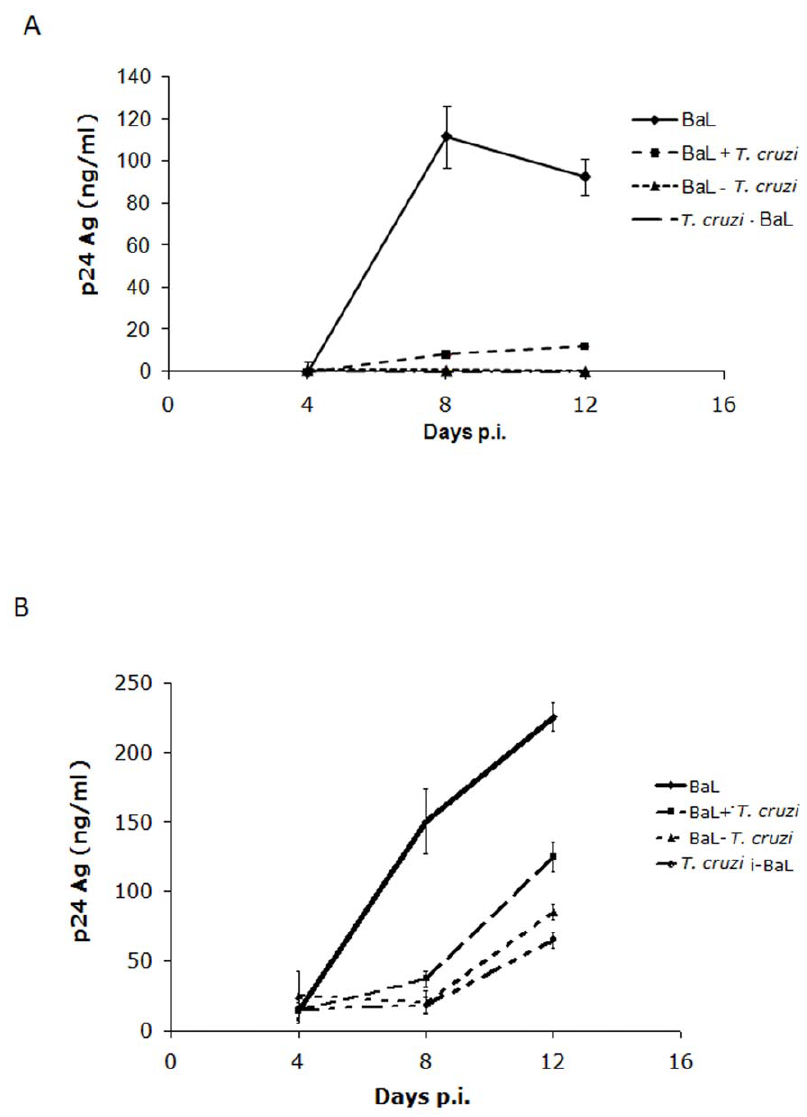
Figure 2. Inhibition of HIV-1 production by T.cruzi in MDM. MDM were infected with HIV in presence of T. cruzi blood trypomastigotes ( A ) or trypomastigotes free-supernatant (TcSn) ( B ) in three different schemes: HIV 24 h after T. cruzi ( T. cruzi -HIV), HIV 24 h before T. cruzi (HIV- T. cruzi) or HIV at the same time as T. cruzi (HIV + T. cruzi ), where T. cruzi indicates either trypomastigotes or TcSn. P24 antigen production was measured at days 4, 8 and 12 p.i. in culture supernatants. Results are expressed as mean 6 SD of triplicates of infection and a representative experiment of at least 3 independent experiments performed with cells from different donors is shown.